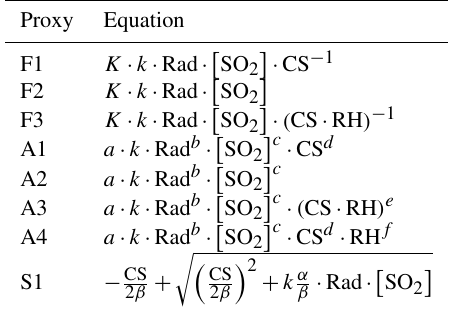
Table 2. Proxy functions. F1 to F3 are the proxies with powers fixed to − 1 or 1 for all variables, as predicted by the existing theory, whereas proxies A1 to A4 have individual adjusted powers for each variable. S1 includes the additional H 2 SO 4 sink related to cluster formation. In each of the proxies, k corresponds to the temperature- dependant reaction rate between SO 2 and OH. Fitting parameters K in F1–F3, a – f in A1–A4 and α − β in S1 were determined itera- tively to minimize the sum of squared residuals associated with each proxy. The pre-factors a and K as well as parameter α are assumed to consider the use of global radiation instead of [OH] in the differ- ent